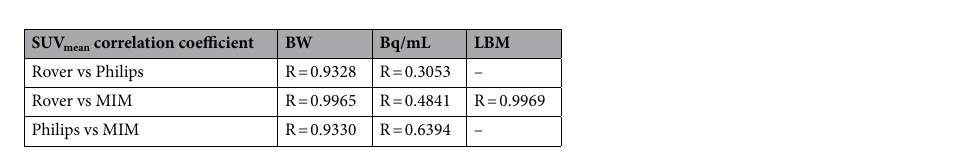
Table 2. Pearson correlation coefficient for SUV mean